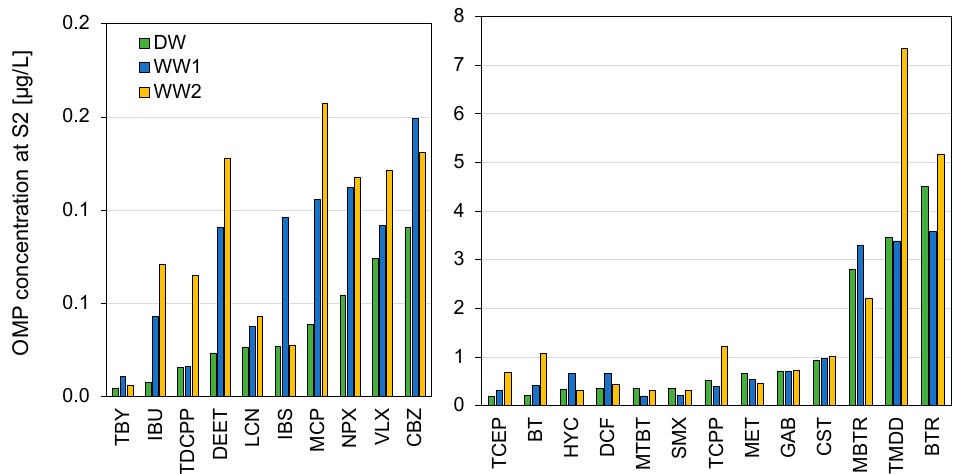
Figure A1. Concentrations of 23 organic micropollutants of dry- (n = 1) and wet-weather sampling (n = 2) at the effluent of PAC (S2).